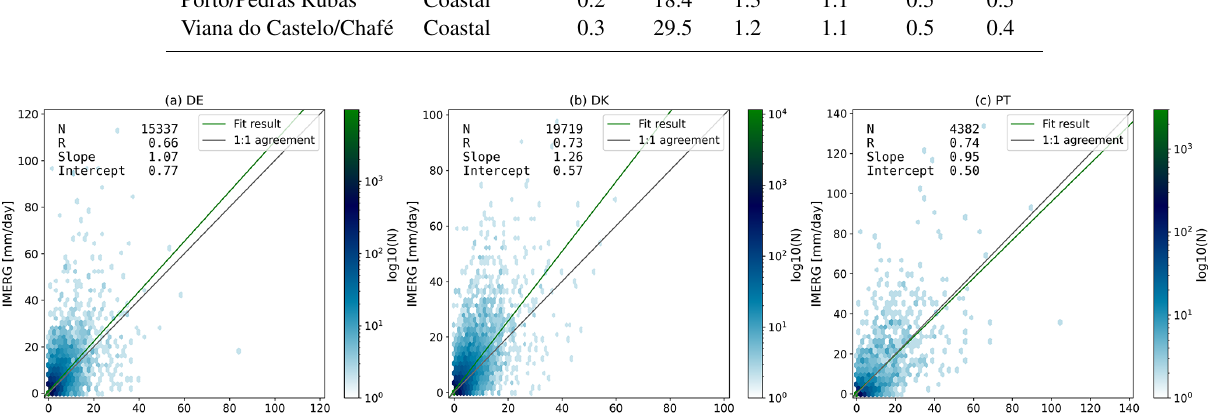
Figure 4. Hexbin plots showing the daily rainfall intensities from IMERG vs. the in situ observations during the period 2014–2019 for (a) German stations, (b) Danish stations, and (c) Portuguese stations. The color of each hexagon indicates the number of samples in it.